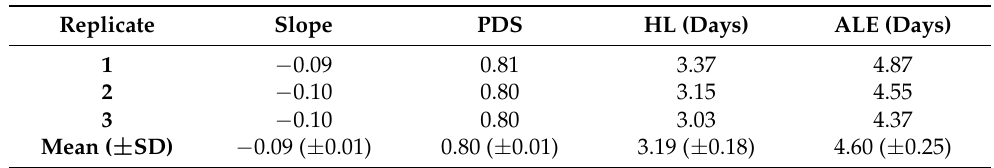
Table 1. Slopes of the regression lines, probability of daily survival (PDS), half-life (HL) and average life expectancy (ALE) of sterile male D. suzukii